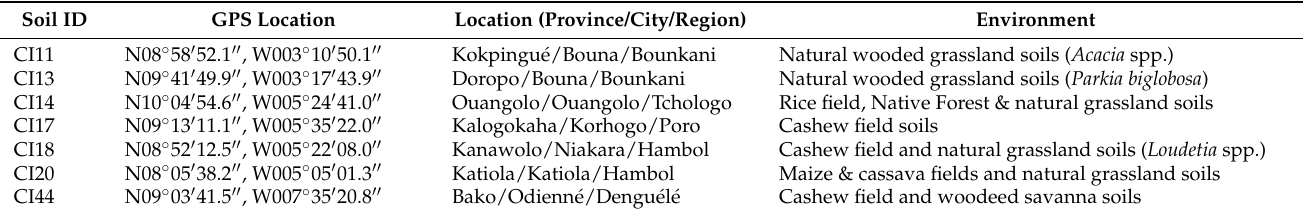
Table 1. The geographic positions and main characteristics of the sampled